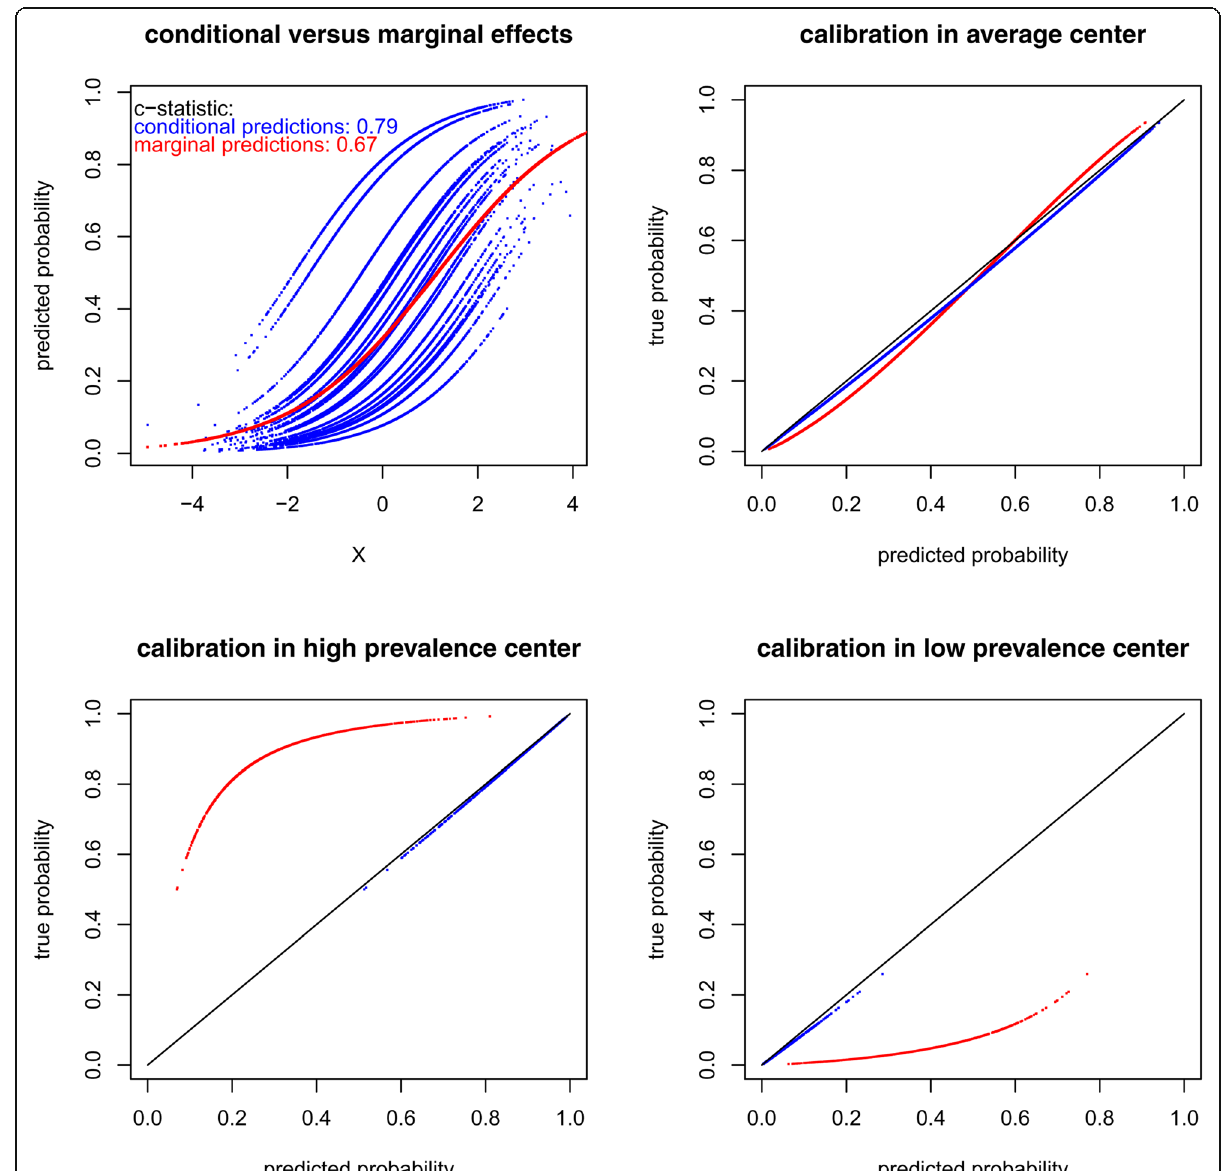
Fig. 5 Didactical example of predictions made ignoring center effects, when differences between centers are very